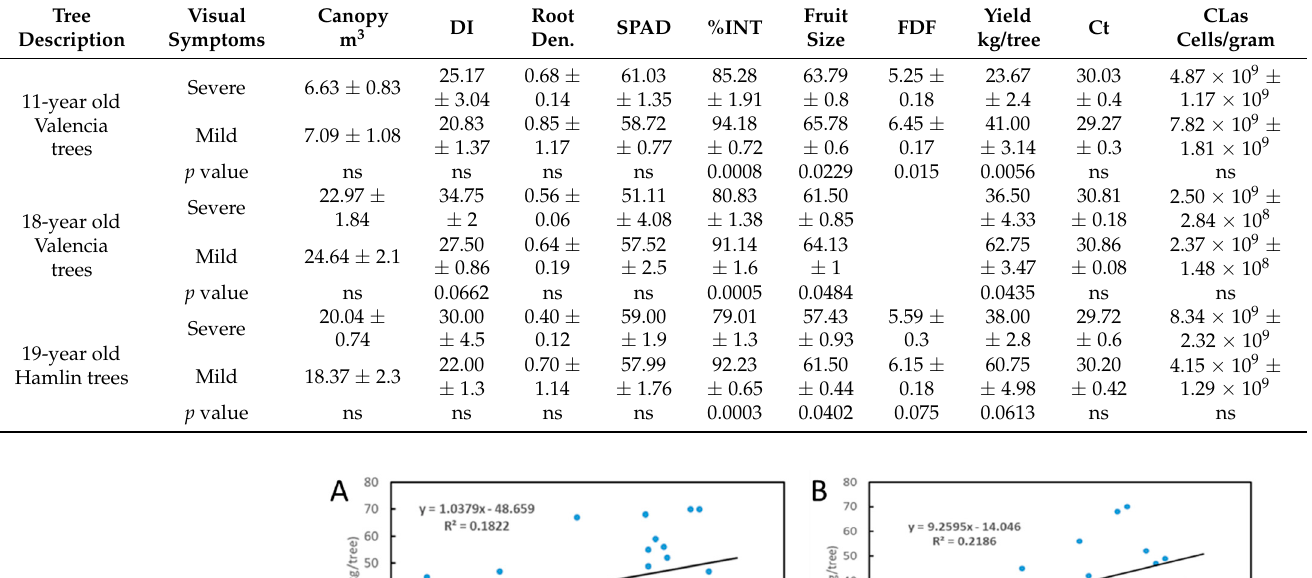
Table 2. Characterizing HLB trees according to %INT.